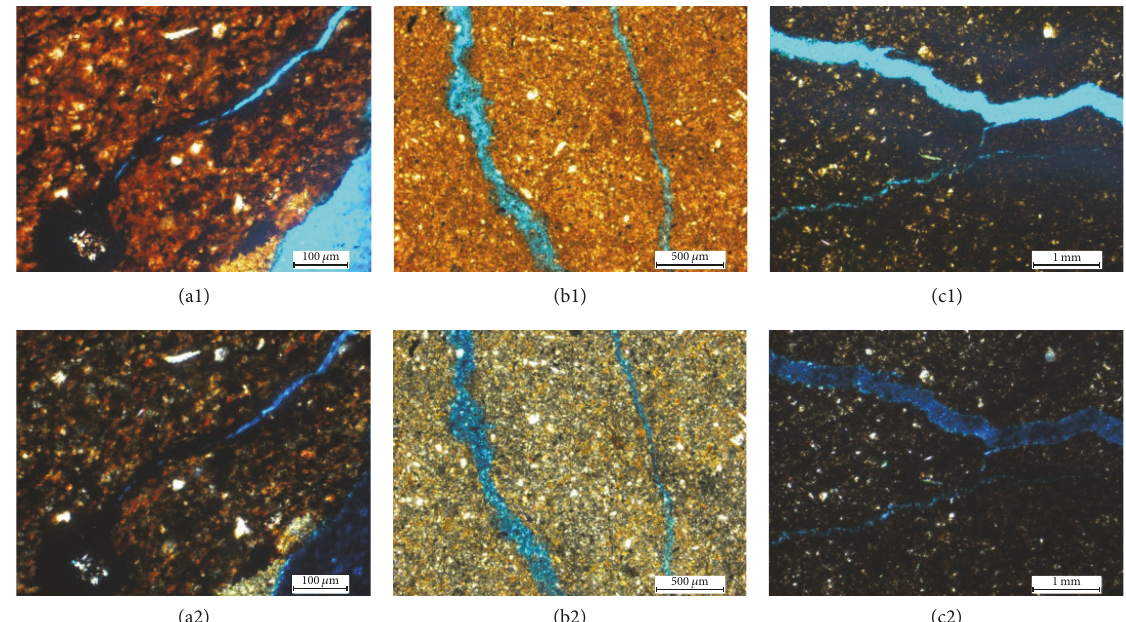
Figure 2: Casting film of three volcanic rock samples under plane polarized light (a1, b1, and c1) and perpendicular polarized light (a2, b2, and c2).